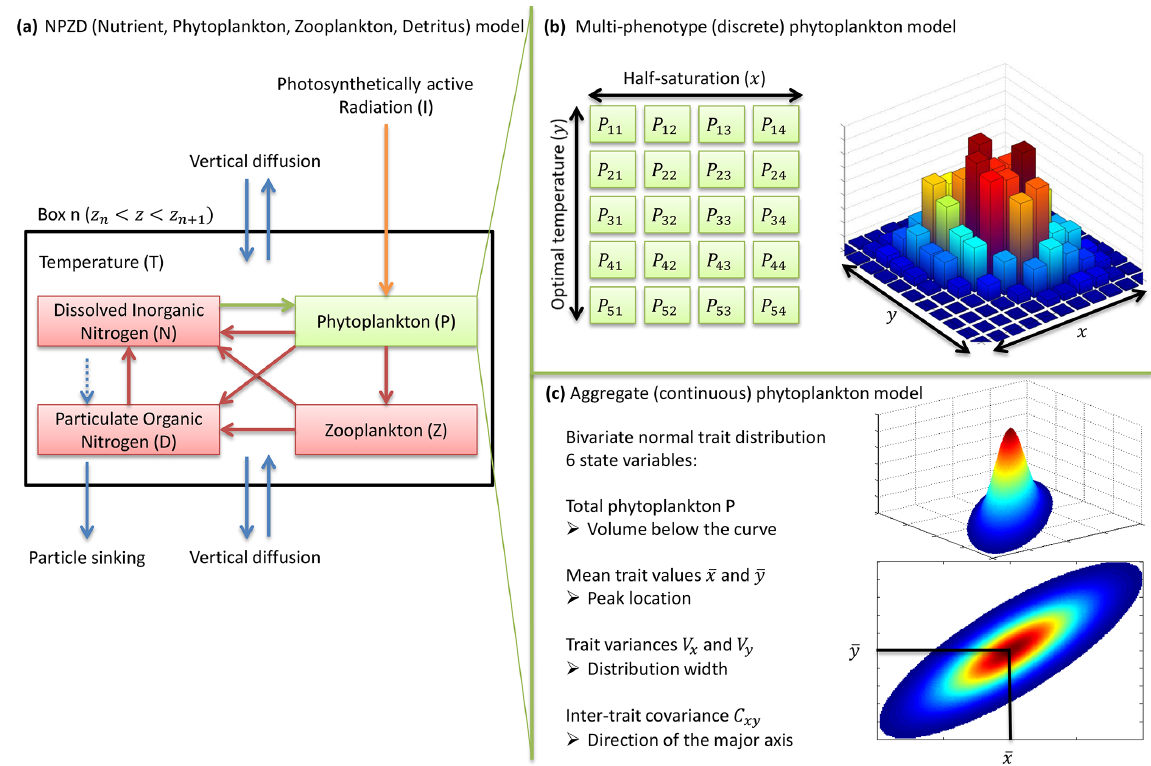
Figure 1. NPZD (nutrient, phytoplankton, zooplankton, detritus) model within its physical setting (a) . The phytoplankton pool is represented by a discrete set of species with different traits (b) or by moments of the trait distributions, assuming a bivariate normal distribution (c) . Colours in (b) and (c) represent phytoplankton